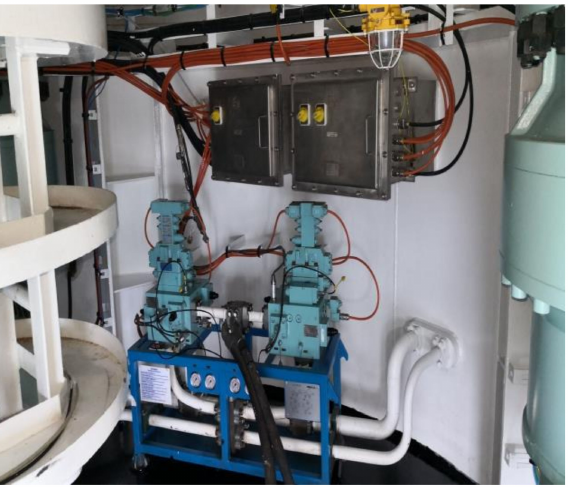
Figure 9. The hydraulic system layout.